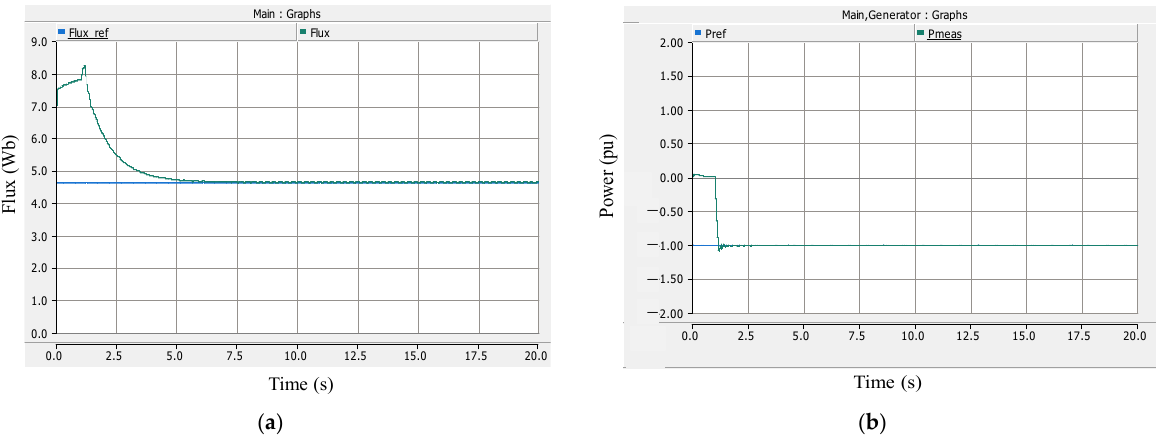
Figure 17. ( a ) Flux control; ( b ) power control at 1.0 pu rotor speed.